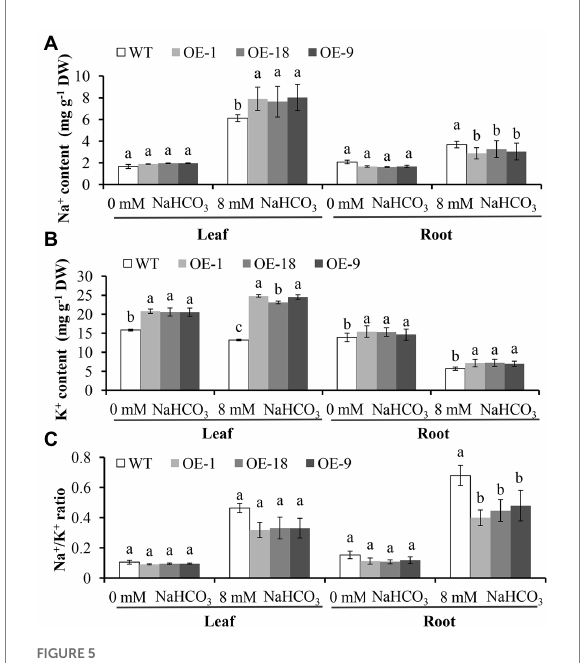
FIGURE 5 Na + content (A) , K + content (B) , and Na + /K + ratio (C) in the leaves and roots of Arabidopsis lines. Arabidopsis lines receiving 0 mM or 8 mM NaHCO 3 treatment for 10 days, respectively. Data represents the mean ± standard deviation of three biological replications and each repeat contained 10 plants per line for each treatment ( n = 30). Bars with the same letter in lowercase above bars indicate no significant differences at the 0.05 level between lines under same treatment according to Duncan’s multiple range